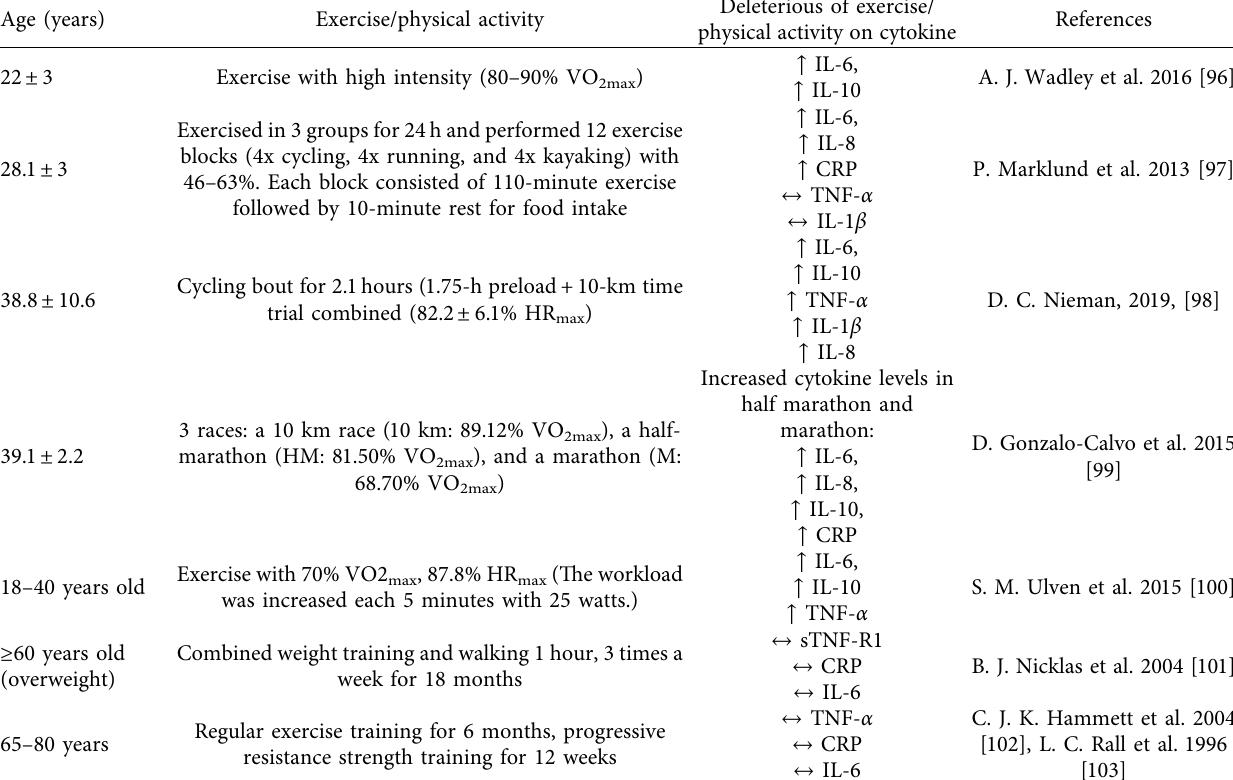
Table 3: The deleterious effects of exercise on cytokines in different age